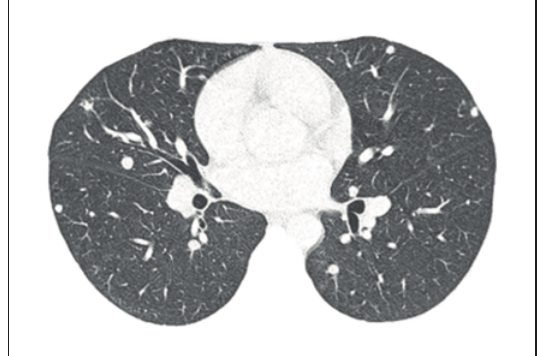
Figure 1. Non-contrast axial scan of thorax: Several macro- and micro-nodular masses (metastases) were found in lung parenchyma